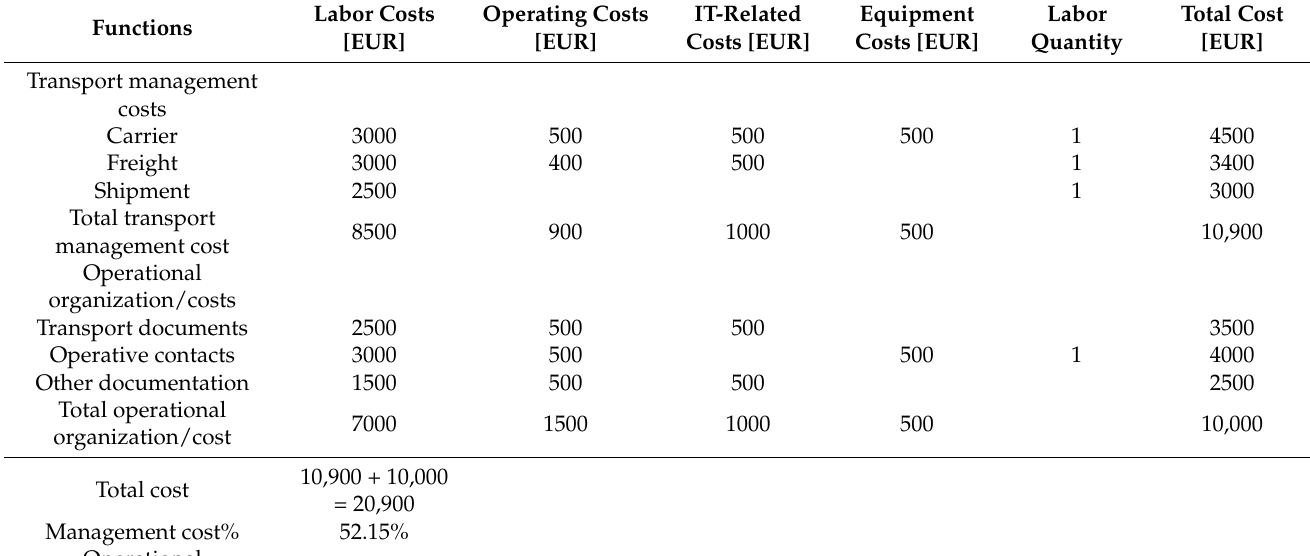
Table 2. Cost [EUR] associated with transport management, organization, and operative activities.